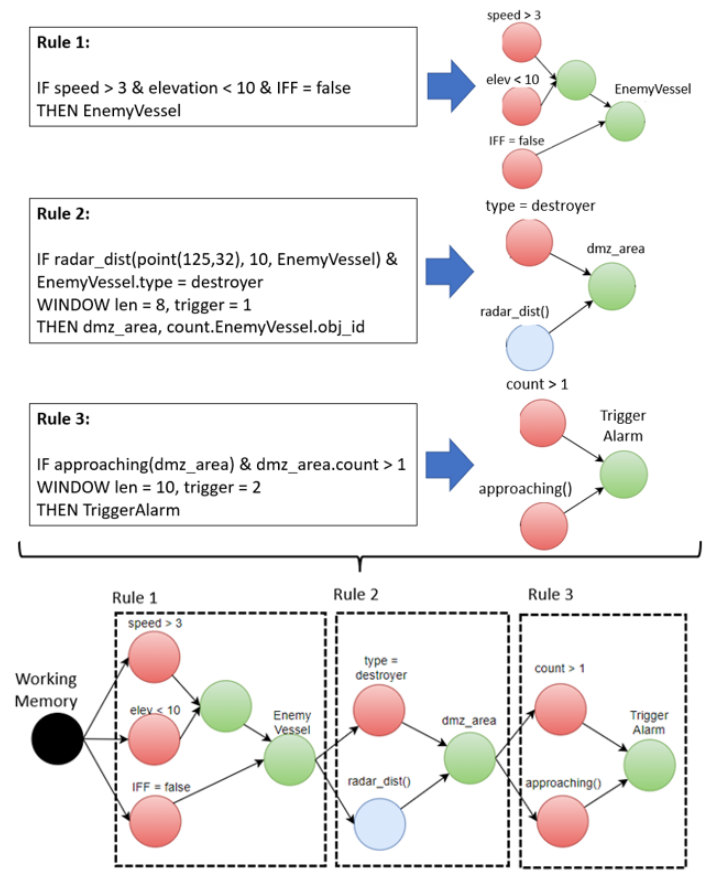
Figure 2. Rete node network for bounded rules.